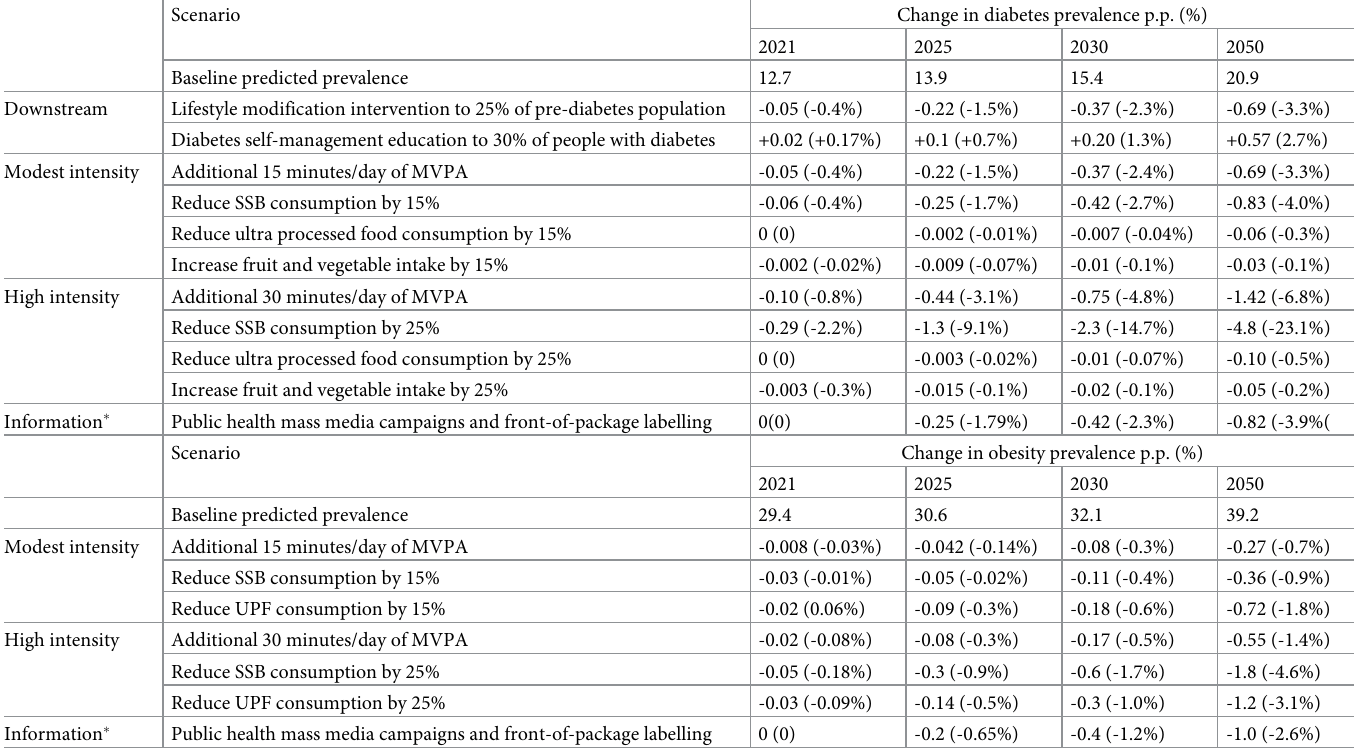
Table 4. Impact of individual changes in dietary patterns and physical activity on diabetes and obesity prevalence.